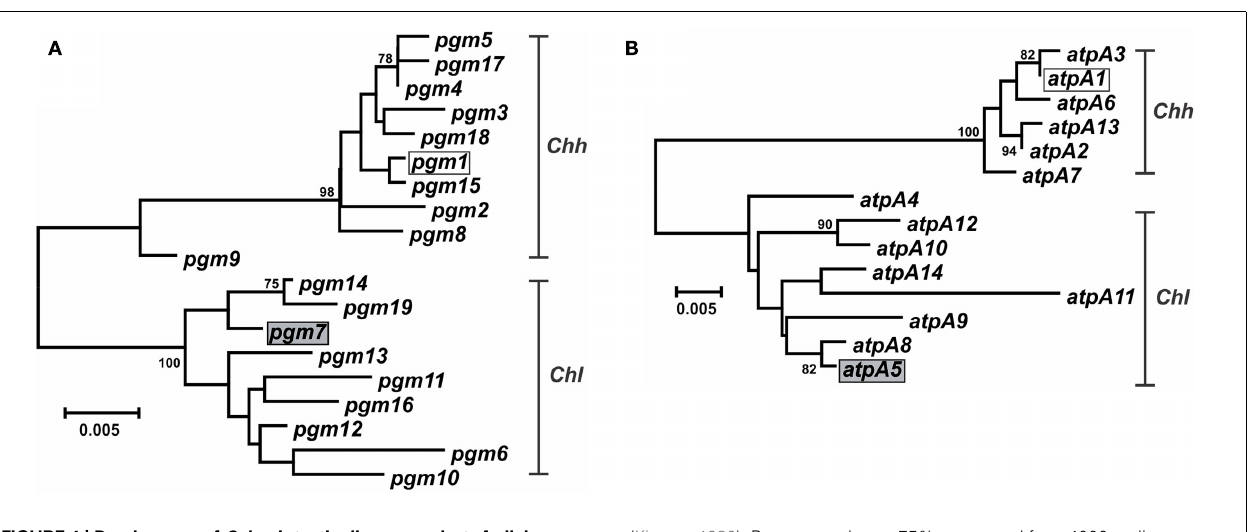
FIGURE 4 | Dendrogram of C. hyointestinalis pgm and atpA alleles. C. hyointestinalis pgm (A) and atpA (B) allele sequences were aligned using CLUSTALX.The dendrogram was constructed using the neighbor-joining algorithm and the Kimura two-parameter distance estimation method